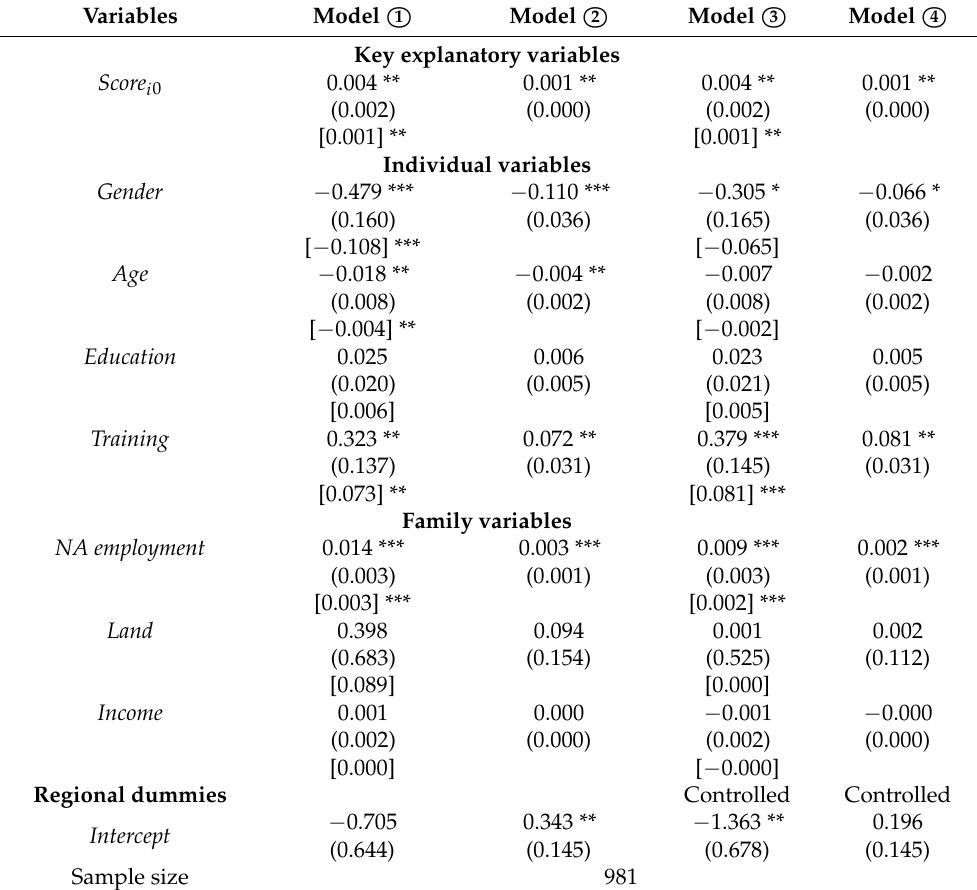
Table 6. Regression results of farmers’ IPM adoption intention (comprehensive agricultural produc- tion